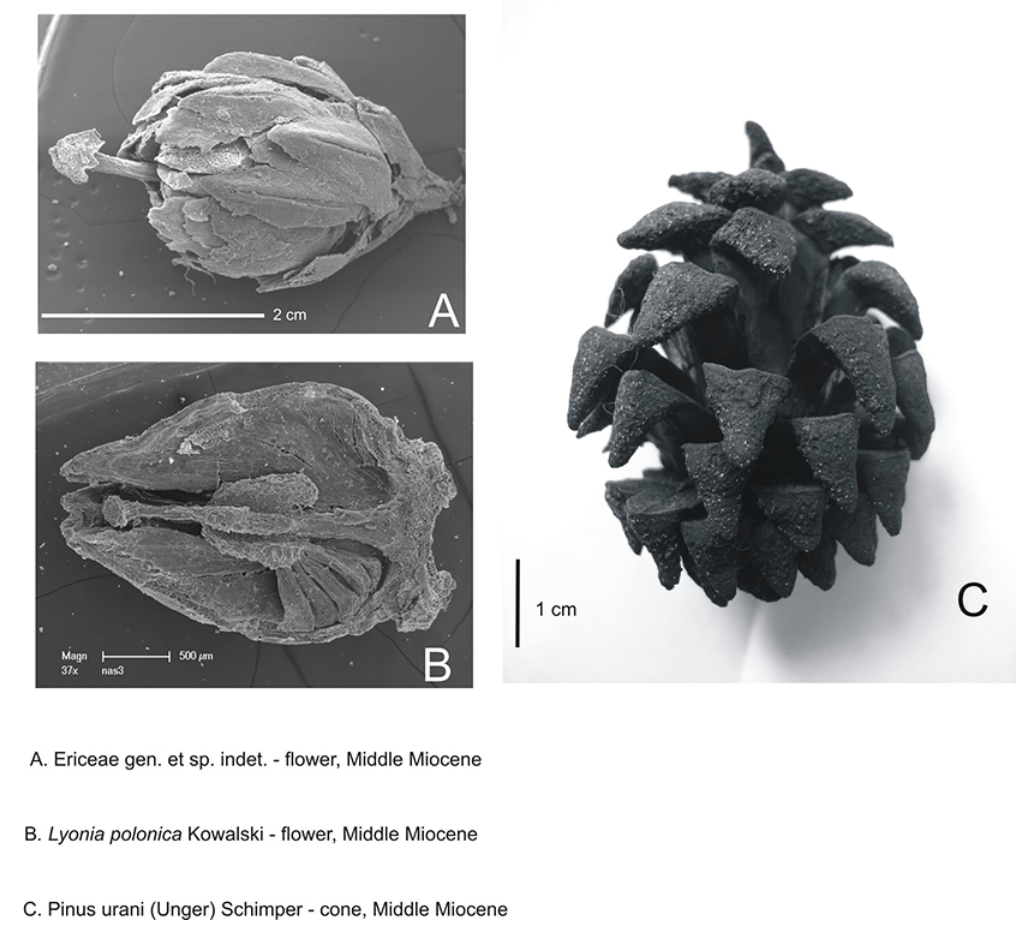
Figure 7 Middle Miocene flowers and cone. Photo: R.